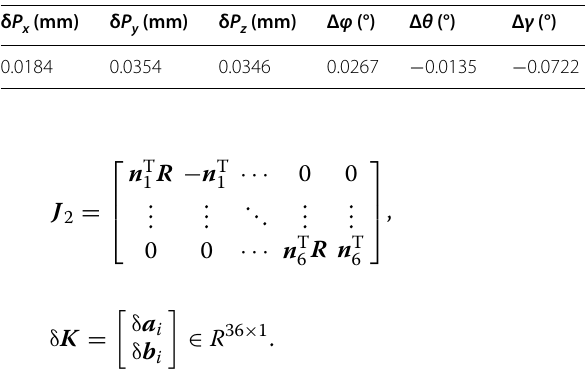
Table 3 Output pose error of